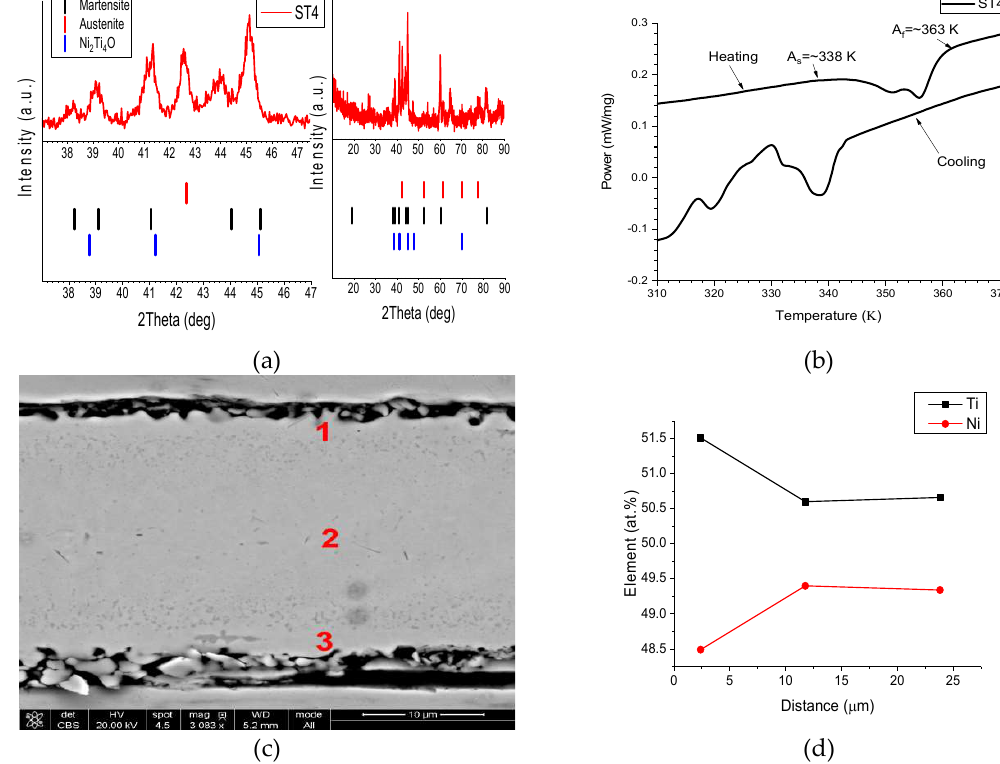
Figure 6. Experimental results for the sample ST4: ( a ) X-ray diffraction pattern, ( b ) differential scanning calorimetry results, ( c ) back scattering image of the cross-section, and ( d ) energy dispersive X-ray spectroscopy point measurements.